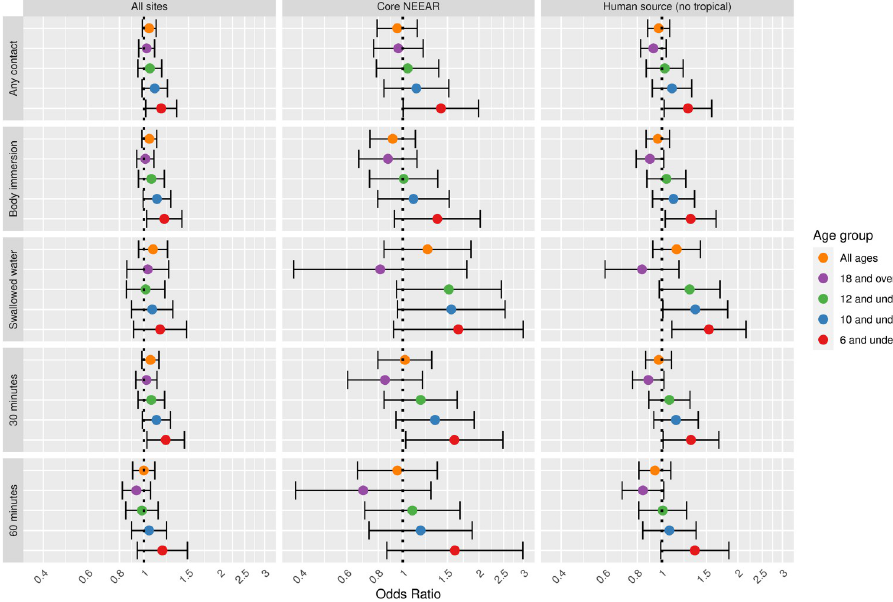
Fig 6. Odds ratios for respiratory illness among swimmers associated with a 1-log 10 increase in Enterococcus qPCR